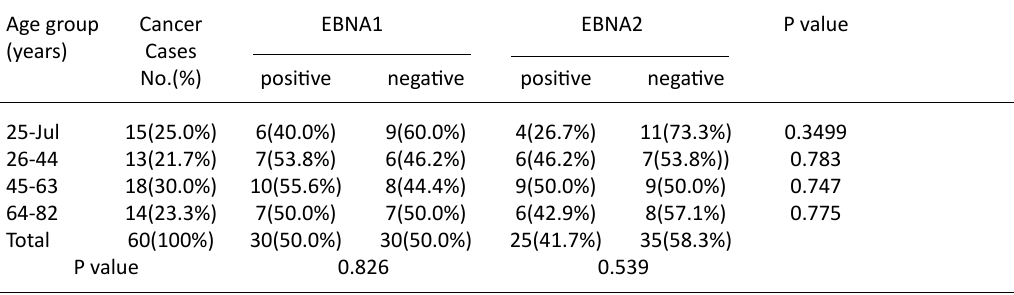
Table 8. Identification of EBNA1, EBNA2 depending of age groups of male cases Age